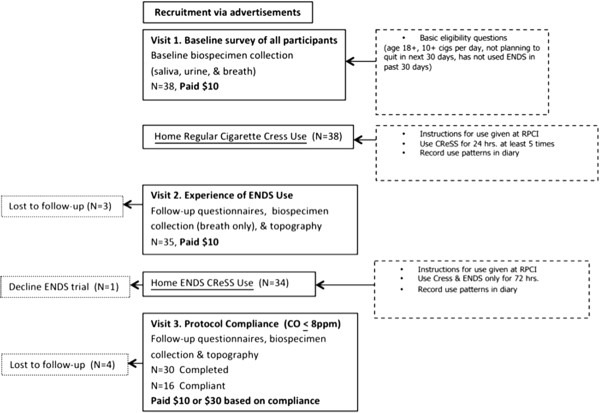
Flowchart of study participation.